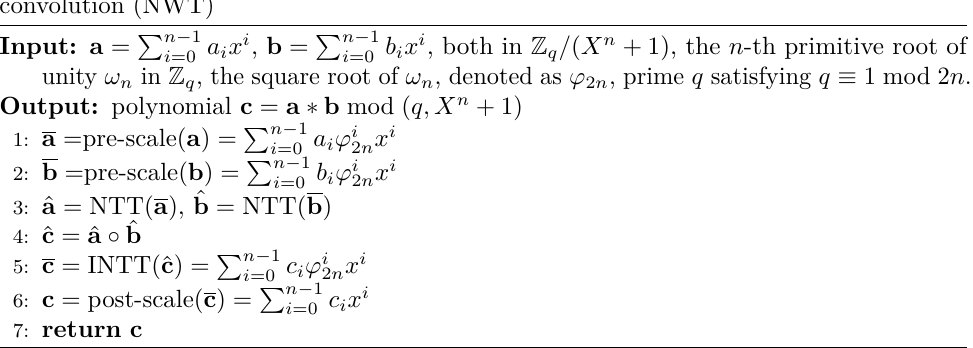
Algorithm 1 Polynomial Multiplication over Z q [ X ] / ( X n + 1) using negative wrapped convolution